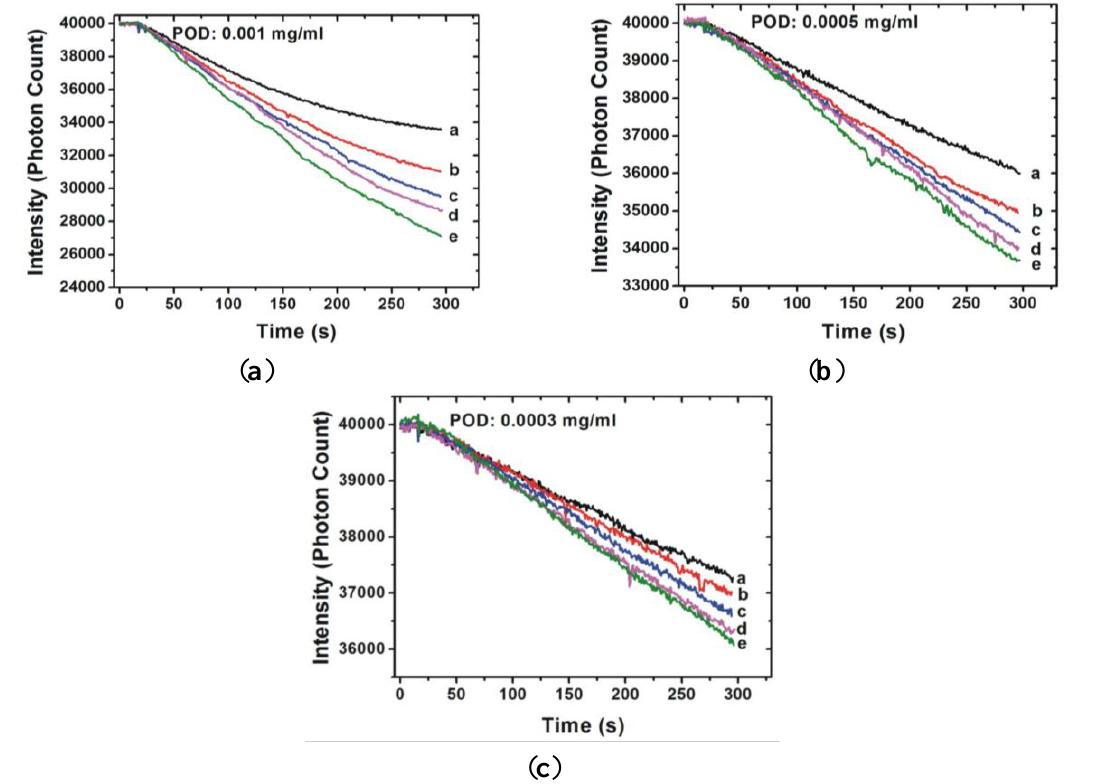
Figure 4. Transmittance-time response behavior of various H 2 O 2 concentrations (a: 0.0001%; b: 0.00015%; c: 0.0002%; d: 0.00025; e: 0.0003%) measured by the sensor with various POD concentrations (( a ) 0.001 mg/mL; ( b ) 0.0005 mg/mL; and ( c ) 0.0003 mg/mL) at monitored wavelengths of 450